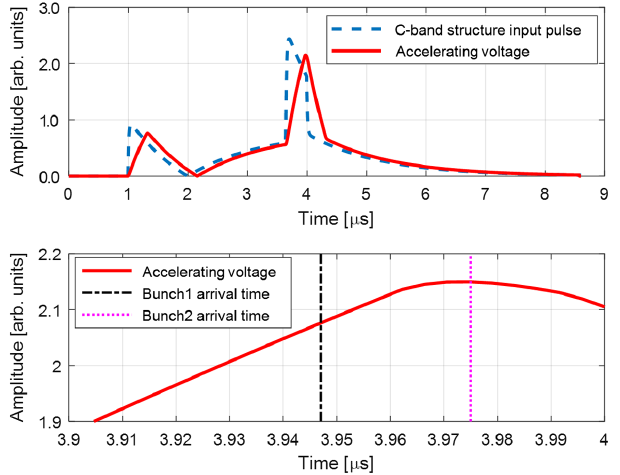
FIG. 4. Input pulse shape and energy gain in C-band stations (upper graph) and magnified energy gain slope and the position of the two bunches on it (lower graph). Note the different time scale for the two graphs. FIG. 5. Panel for rf